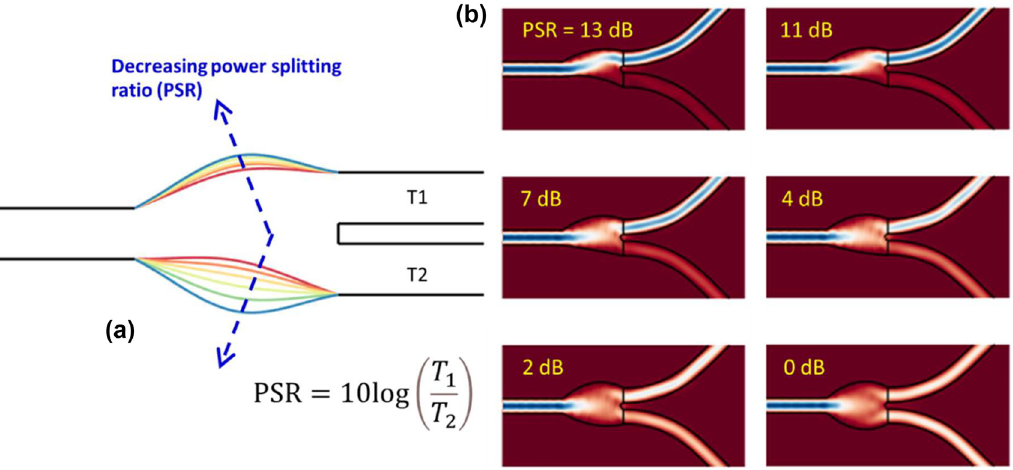
Figure 6: Inverse-designed silicon photonic power dividers. (a) Scaled view of the inverse-designed power dividers for various PSR levels. [Shown in different colors]. (b) FDTD simulations showing flow of power in the power dividers with various PSR levels.